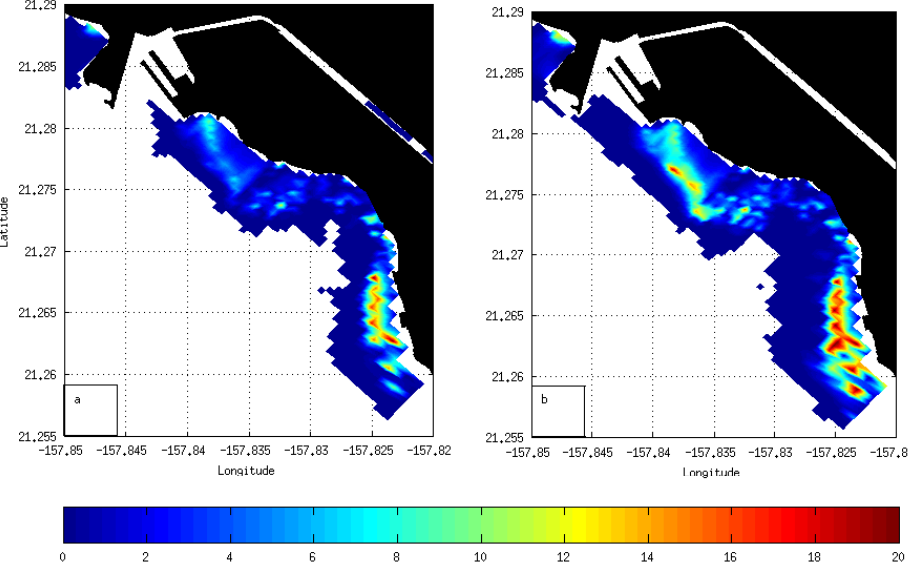
Figure 11. Maps of the time mean wave energy dissipation by depth-induced wave breaking (Wm − 2 ) for the WAVECOUPLE experi- ment 1 (a) and experiment 2 (b) . The depth-induced wave breaking was the most significant wave dissipation term. The energy dissipation was concentrated in the western and eastern portions of Waikiki due to the reef bathymetry (see Fig. 1). The larger dissipation in (b) is due to the large wave heights of experiment